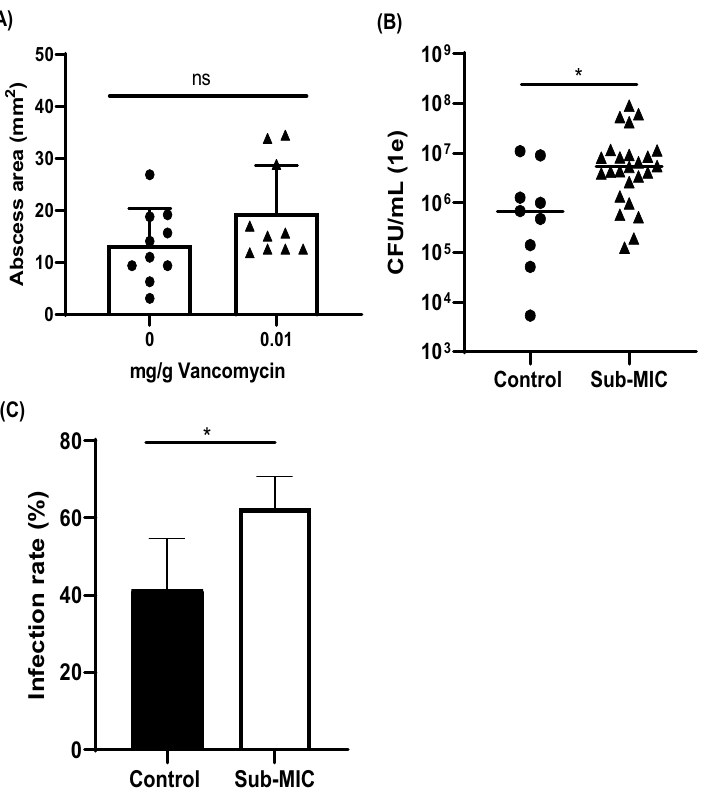
Figure 4. Sub-MIC vancomycin increases bacterial growth and infection in vivo. Mouse abscess model inoculated with 1 × 10 7 CFU/ml JE2. S. aureus and treated with sub-MIC vancomycin (0.01 mg/g) for 3 days. ( A ) There were no differences between treatment groups for total abscess area n = 10 per group. ( B ) For bacterial burden, the abscess burden was significantly greater in the sub-MIC group at 3 days post infection n = 10 per group. ( C ) Sub-MIC vancomycin treatment results in a higher infection rate in mice. Results are from 5 independent experimental trials. Error bars represent standard deviation. *p <